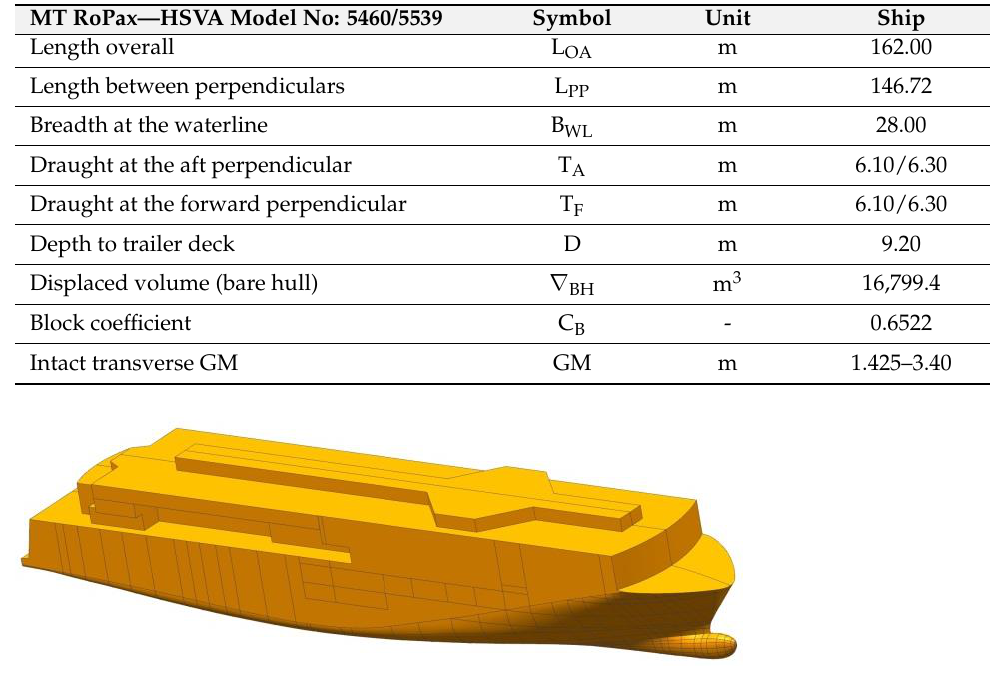
Table 1. Main data of the vessel in intact (test) condition.